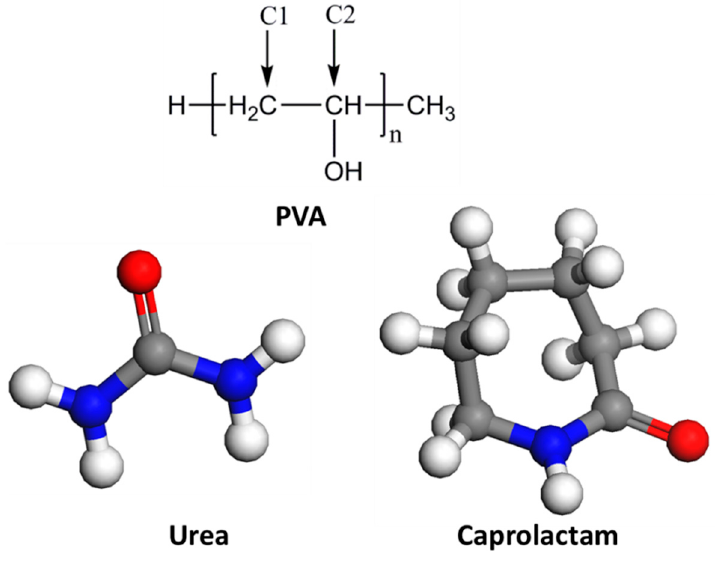
Figure 1. The chemical structure of PVA and the ball-and-stick model of urea and caprolactam molecules.